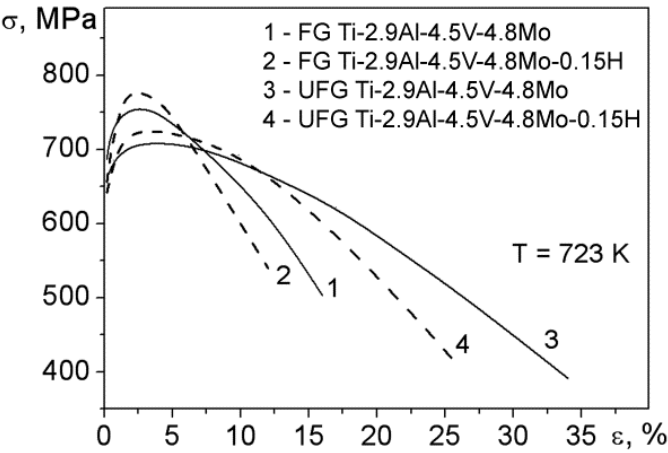
Figure 5. Tension curves of the FG and UFG Ti-2.9Al-4.5V-4.8Mo and Ti-2.9Al-4.5V-4.8Mo-0.15H alloys at 723 K. alloys at 723 K.